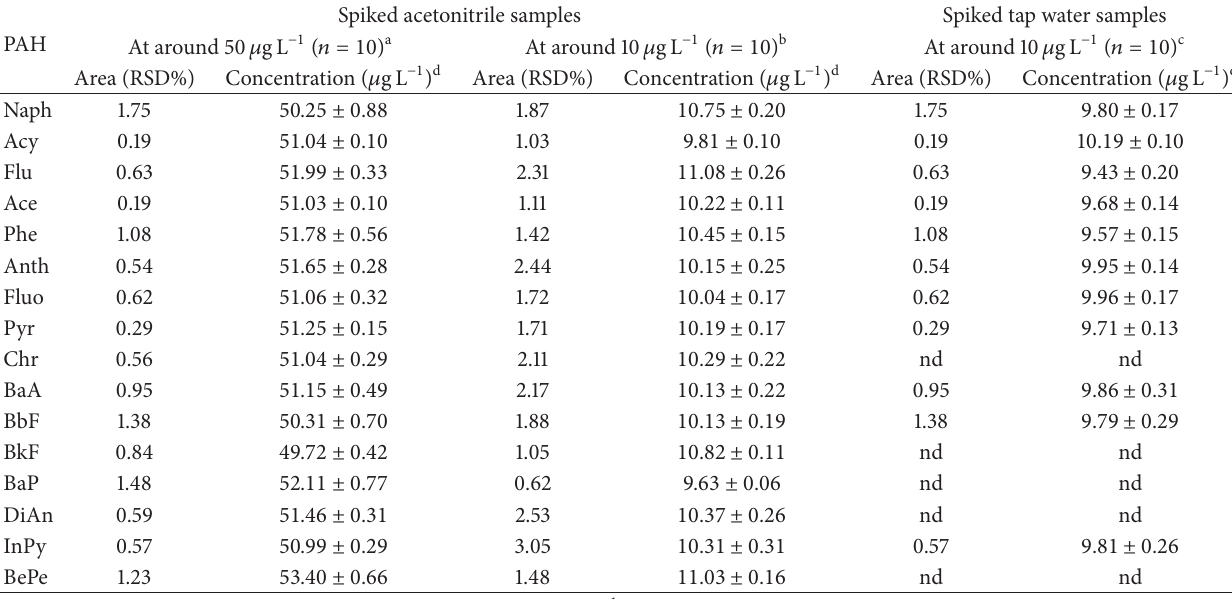
53.40 ± 0.66 11.03 ± 0.16 nd nd a Acetonitrile samples were spiked with a mixture of PAHs at around 50 𝜇 gL −1 . b Acetonitrile samples were spiked with a mixture of PAHs at around 10 𝜇 gL −1 . c Tap water was spiked with a mixture of PAHs (Naph, Acy, Flu, Ace, Phe, Anth, Fluo, Pyr, BaA, BbF, and InPy) at around 10 𝜇 gL −1 . These PAHs were selected from their solubility values in water. d Concentrations were expressed as mean ± SD. nd: not